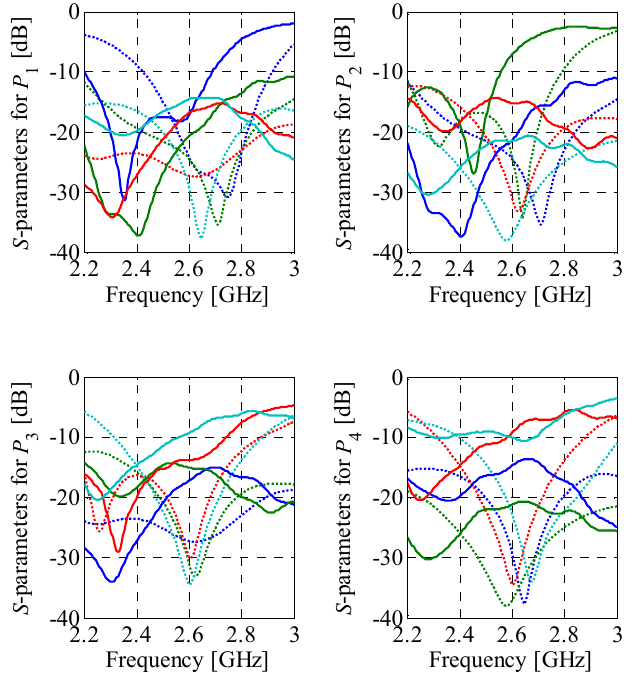
Figure 15. Butler matrix 2: comparison of measurements (––) with EM simulations (···) in terms of reflection/isolation. Here, the EM simulation model does not account for systematic errors.